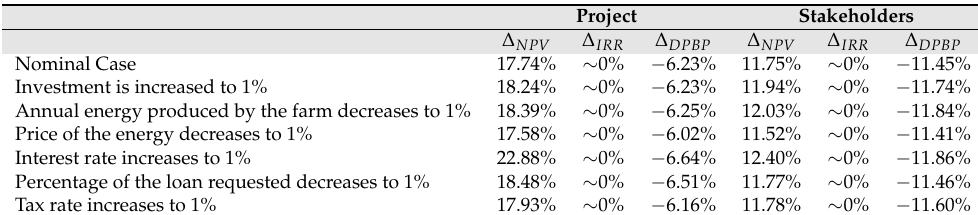
Table 3. Comparative sensitivity analysis results for the use of automated maneuvers when compared to the use of manual